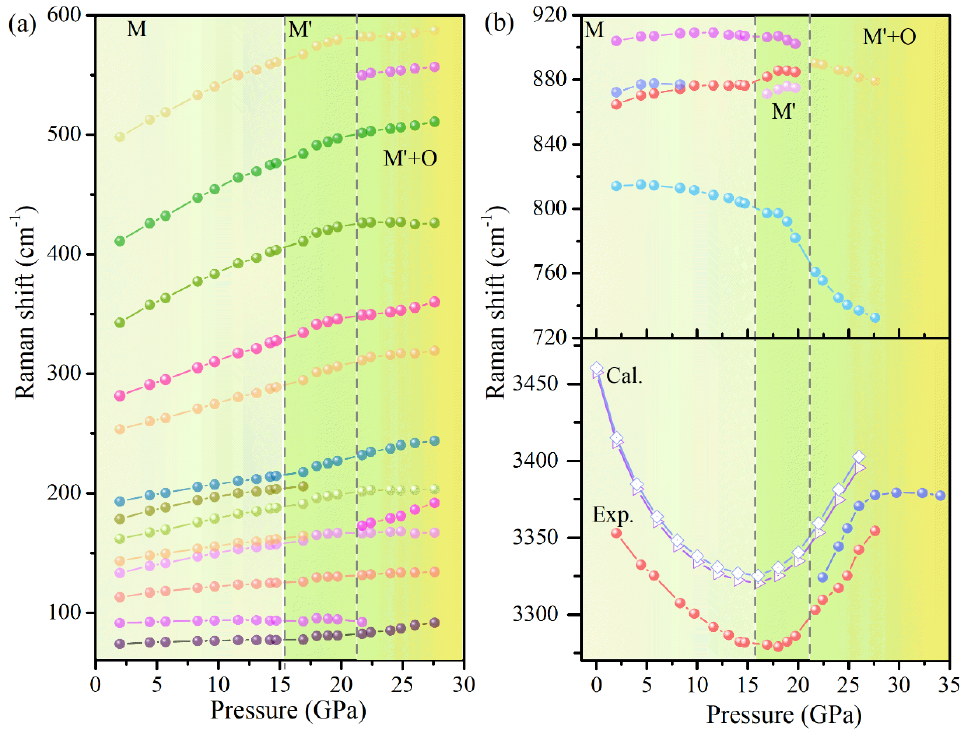
Figure 7. Experimental frequency versus pressure for the Raman active modes of Cu(OH)Cl and theoretical pressure dependence of the O–H stretching modes. ( a ) The lattice modes involving the deformation or relative displacement of the Cu(OH) 3 Cl 3 octahedra. ( b ) Raman active bending and stretching modes of O–H group. In order to track the electron band gap evolution with pressure, UV/Vis absorption